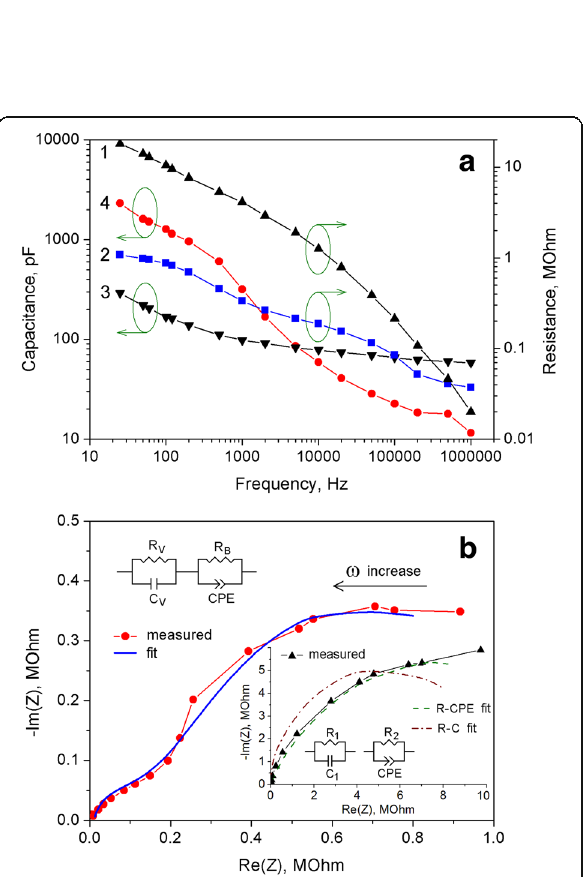
Fig. 7 a Frequency dependence of the electrical resistance (curves 1 and 2 ) and the capacitance (curves 3 and 4 ) of the PS (curves 1 and 3 ) and PS – RGO structures (curves 2 and 4 ). b Nyquist plot and equivalent circuit diagram of PS – RGO structure. Inset : Nyquist plot and equivalent circuit diagrams of the PS structure